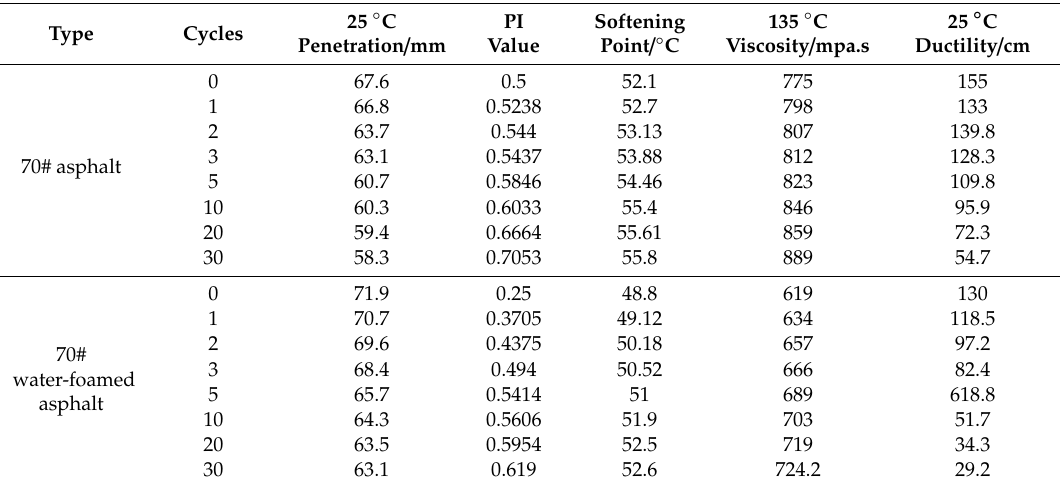
Table 2. Conventional physical properties test results of foamed and non-foamed asphalt with low-temperature frozen